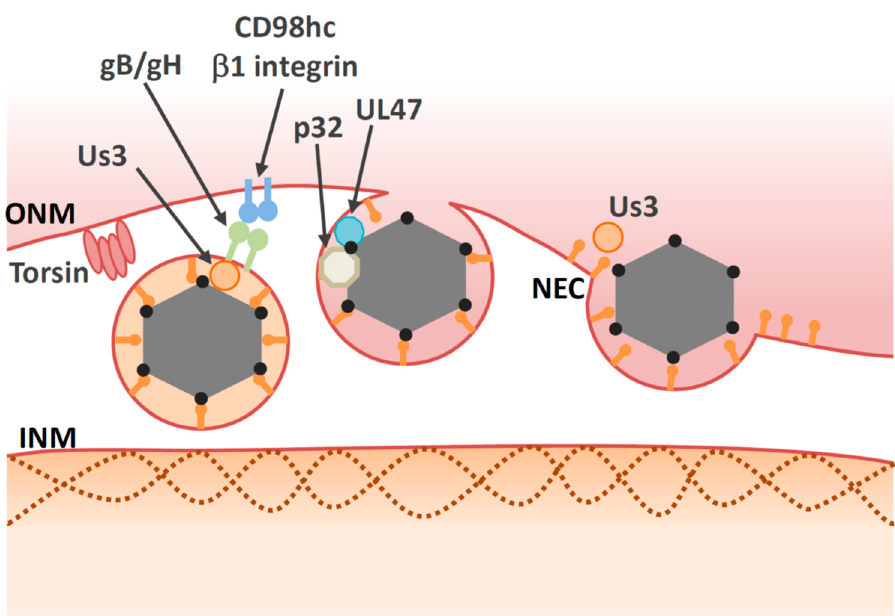
Figure 3. Multiple proteins are involved in the de-envelopment step. Some viral proteins, such as gB/gH and Us3 may be involved in the de-envelopment step, but their roles are unclear. Us3 may induce disassembly of the NEC lattice. Torsin and p32 promote de-envelopment through unidentified mechanisms. Viral protein UL47 interacts with cellular protein p32. The CD98hc/ β 1 integrin complex may influence fusion activity of the primary virions.